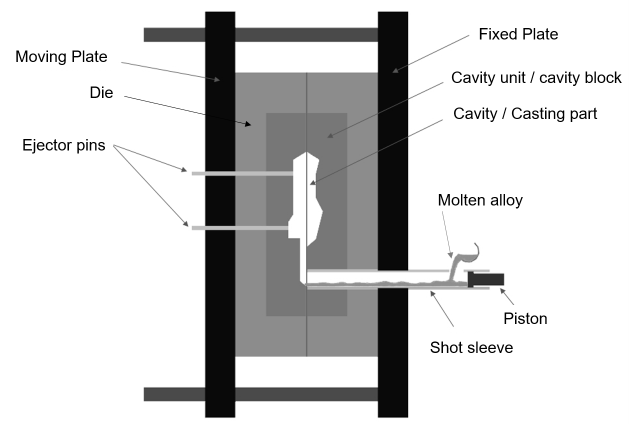
Figure 2. Cold-chamber high-pressure die casting schema.